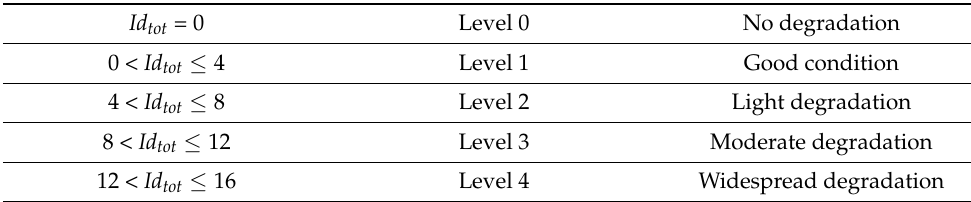
Table 1. Degradation index values Id tot